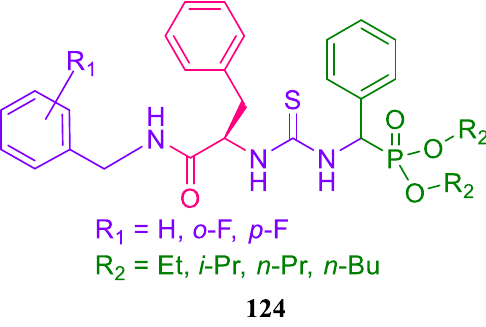
α -aminophosphonate analogues. Figure 101.